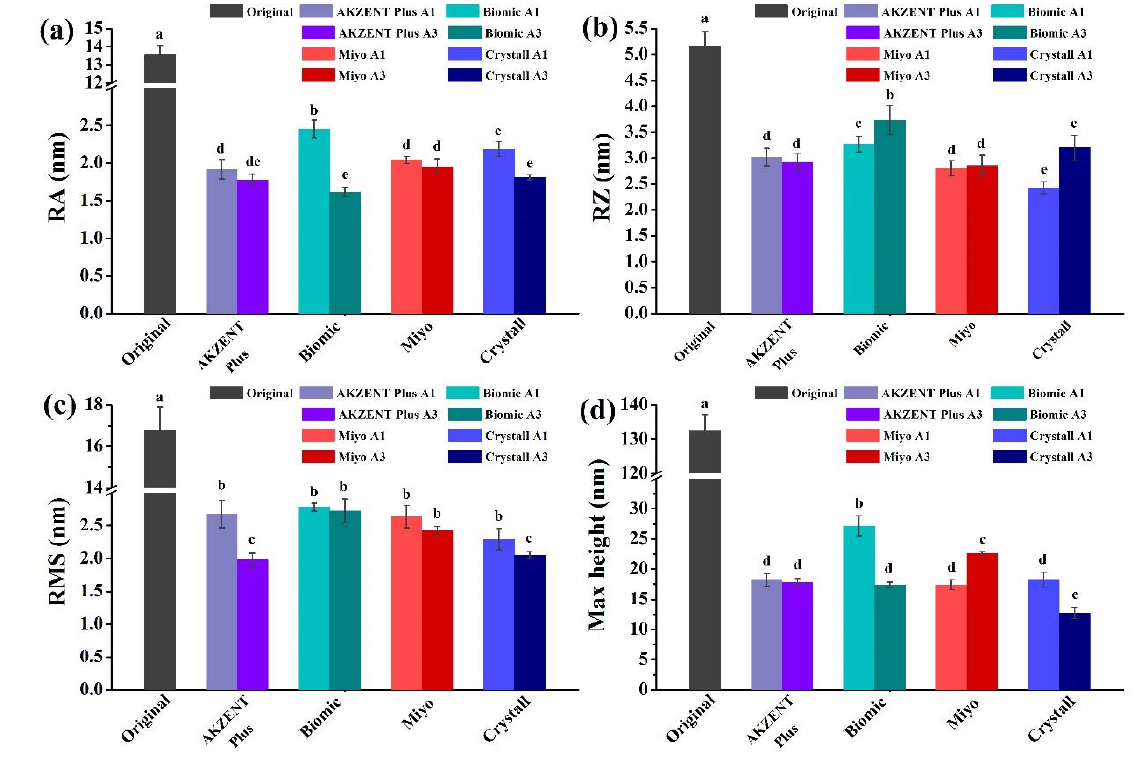
Figure 9. Surface roughness test of the zirconia samples. ( a ) Roughness Average, ( b ) root mean square, ( c ) maximum height of profile, and ( d ) maximum height. Means with different letters were significantly different ( p < 0.05, mean ± SD, n = 5).